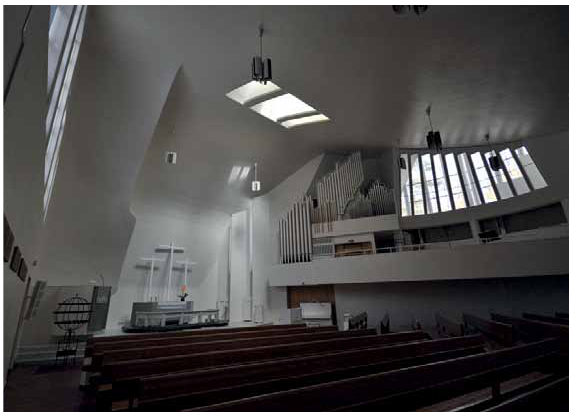
fig. 8. Vuoksenniska Church, alvar aalto. Source: